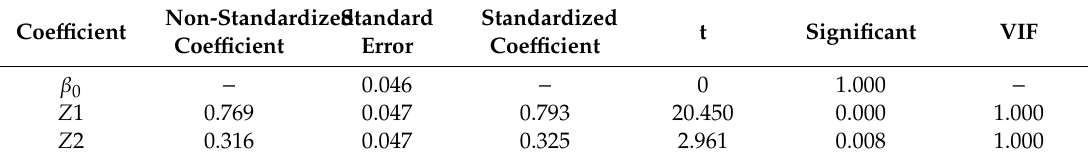
Table 9. Component coe ffi